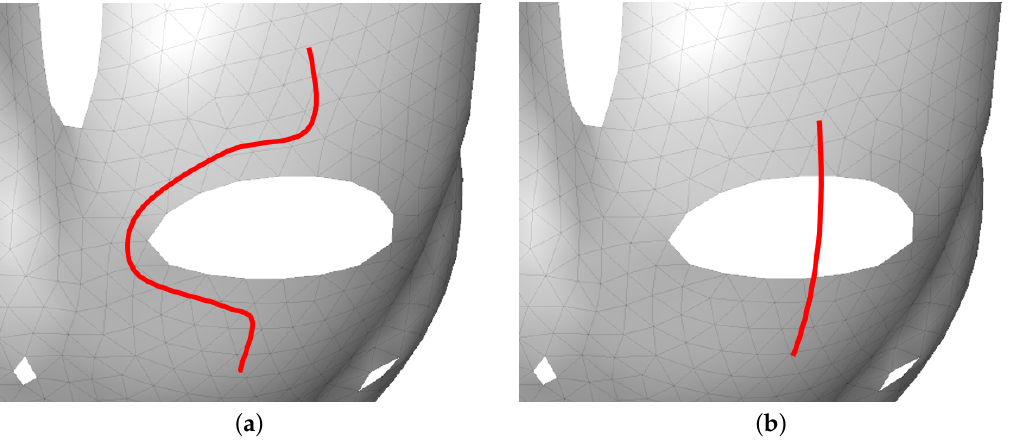
Figure 5. Multidimensional scaling (MDS) parameterization Φ = [ geodesic distances.